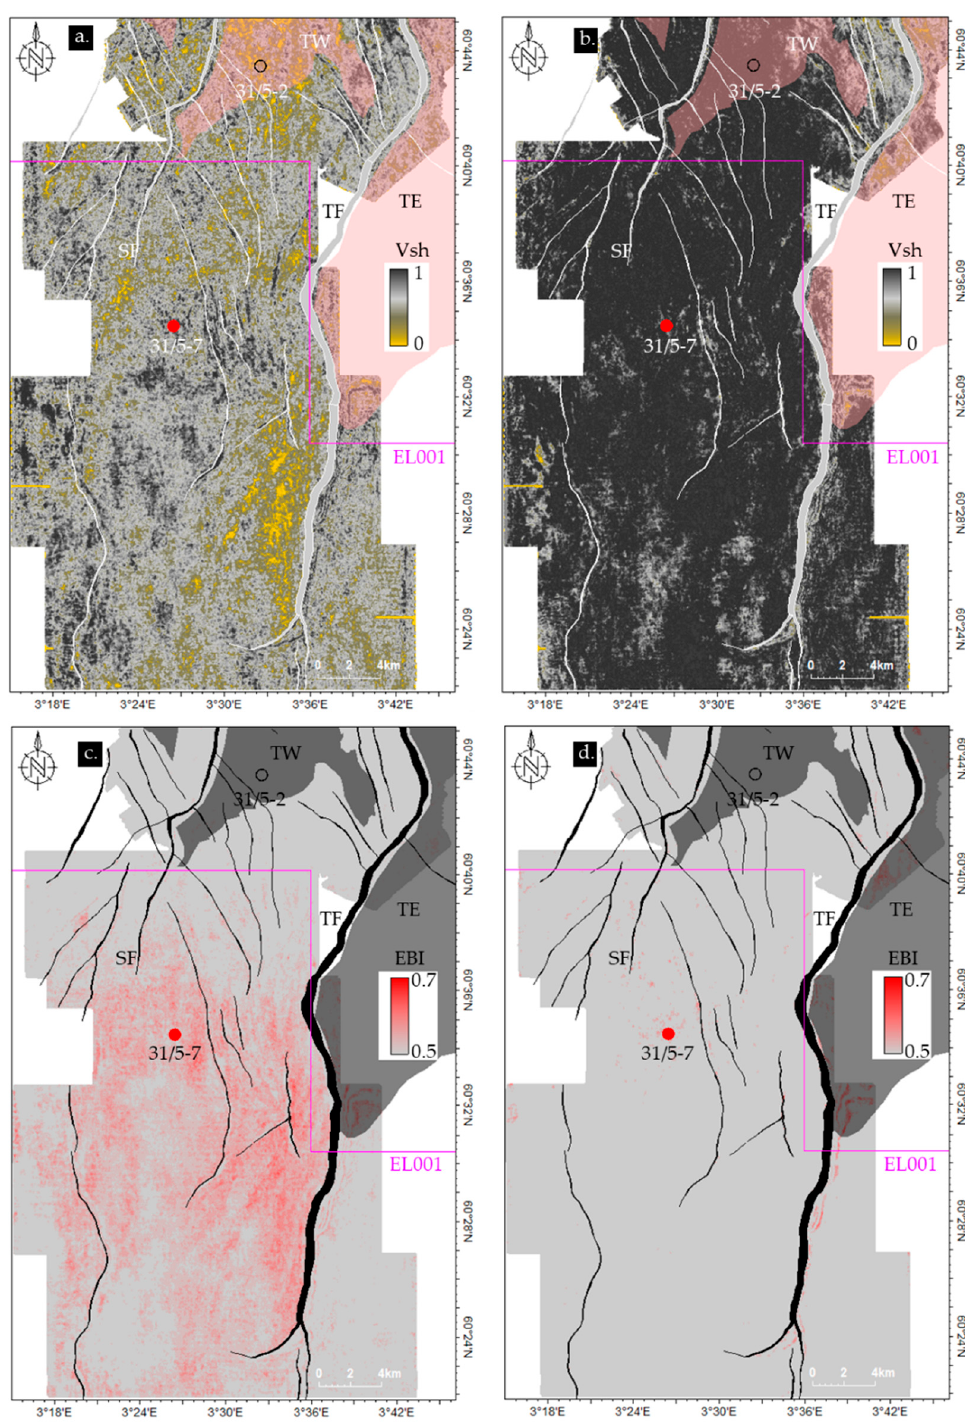
Figure 15. The extracted volume of shale property maps illustrated on top of the upper Drake ( a ) and lower Drake ( b ) units. The elastic brittleness indices property estimated using Equation (4) is also presented on top of the upper Drake ( c ) and lower Drake ( d ) units. The faults and hydrocarbon fields located in the study area are also presented. In addition, the first CCS license (EL001) and the proposed CO 2 injection well (31/5-7) are shown.